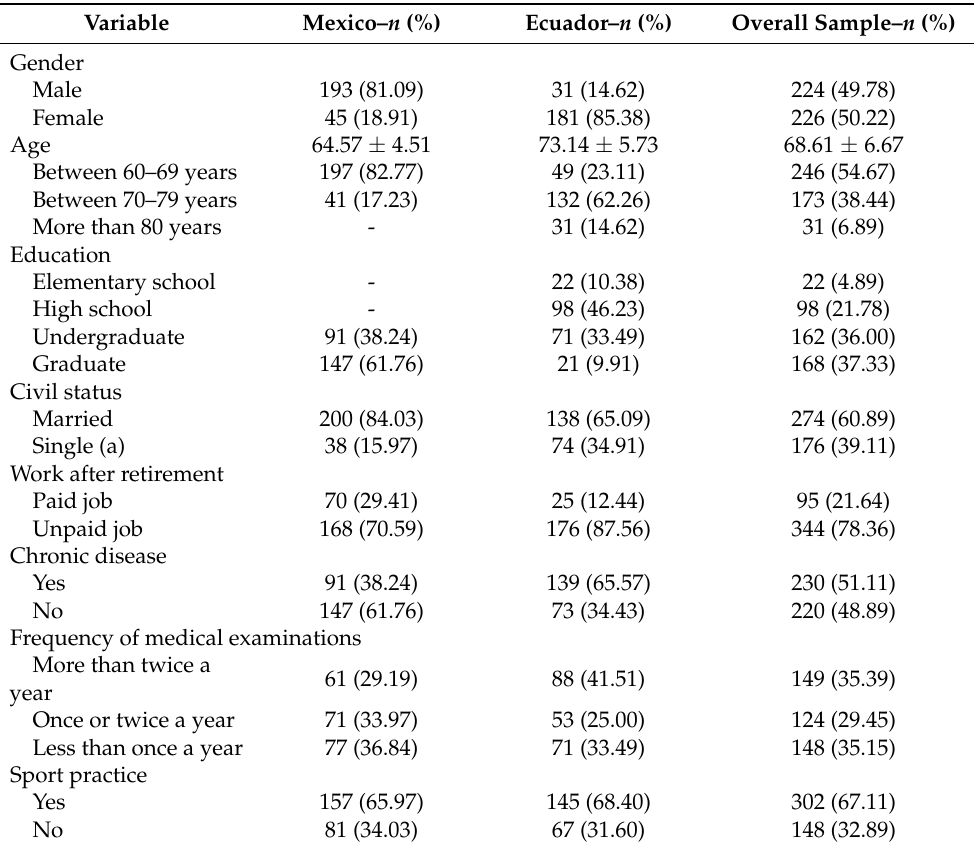
Table 1. Sociodemographic